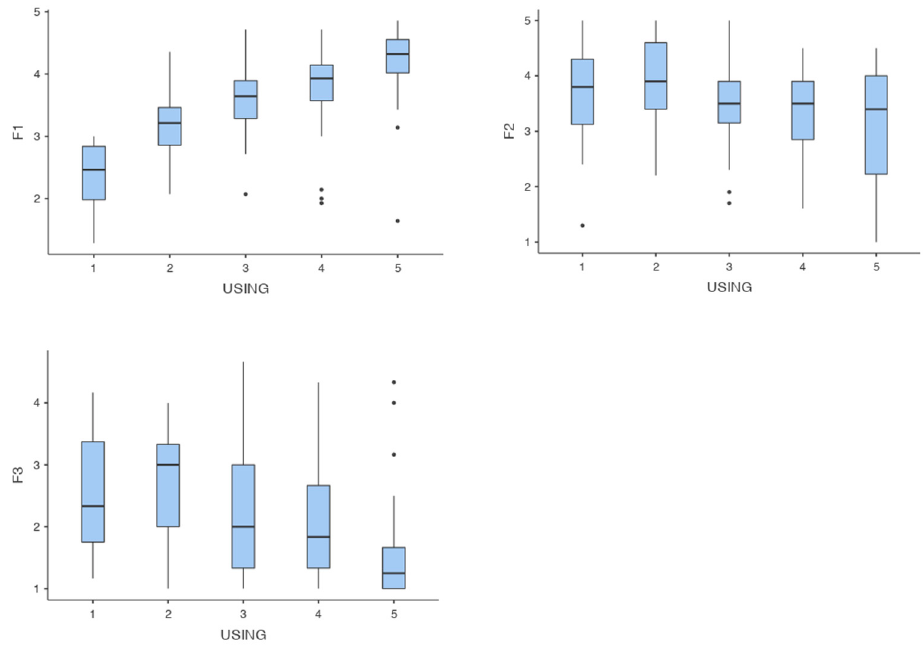
Figure 2. Boxplots of the factors by response option to the tendency to use BD